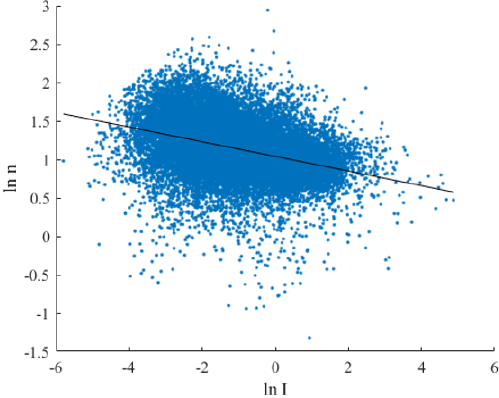
Figure 8. Evaluation of Eq. (7) to derive the constants N and q